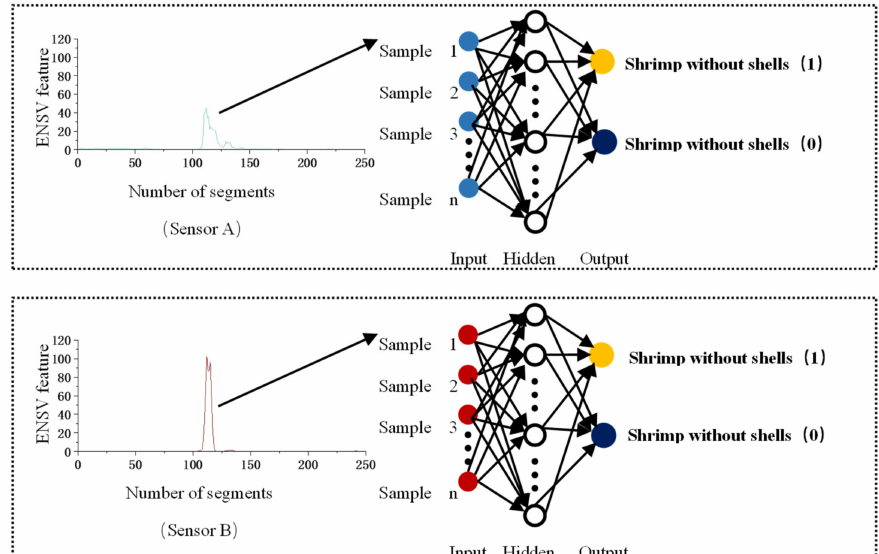
Figure 5. Pretraining flow chart.